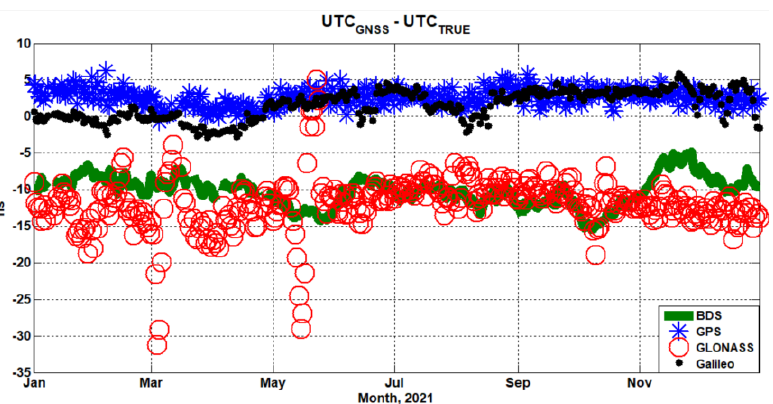
Figure 4. The comparison time transfer error UTC GNSS -UTC true for BDS, GPS, GLONASS, and Galileo.